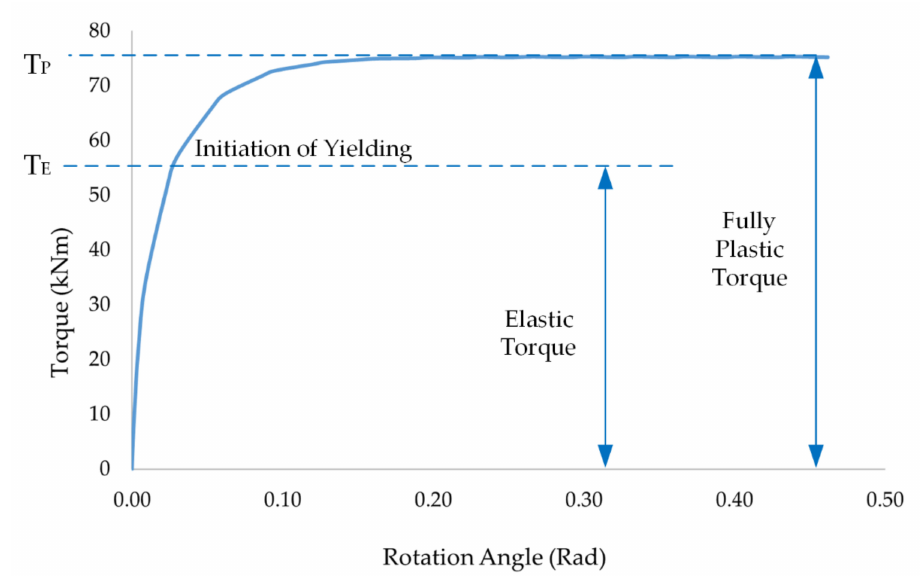
Figure 19. Torque vs. the rotation angle for 240 µ m interference.